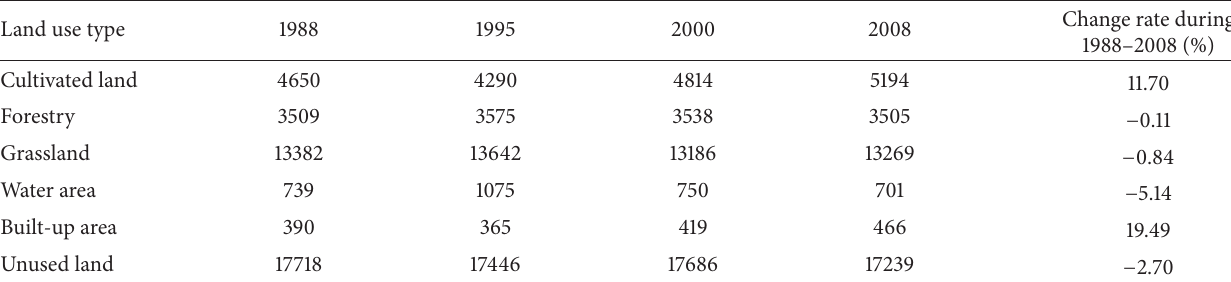
Table 3: Land use changes during 1988–2008 (unit: km 2 ).